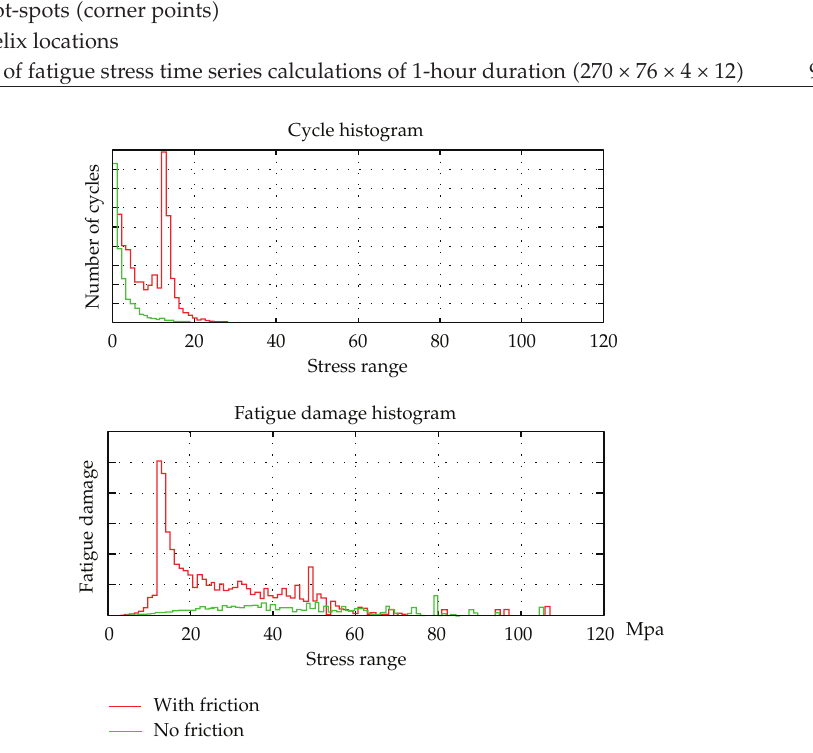
Figure 14: Long-term cycle histogram and fatigue damage at most critical hot-spot